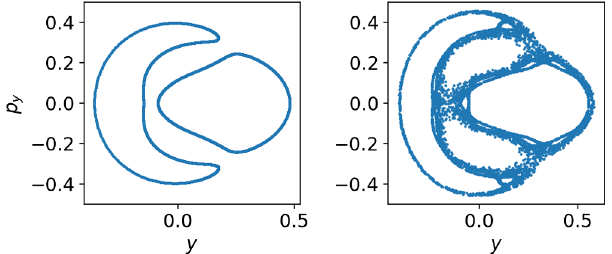
FIG. 4. Dynamic aperture of x ¼ 0 and E ¼ 1 = 12 surface projected on y − p plane. The color bar corresponds to the y for the left and Δ for the right. measure of chaos Δ FMA REM